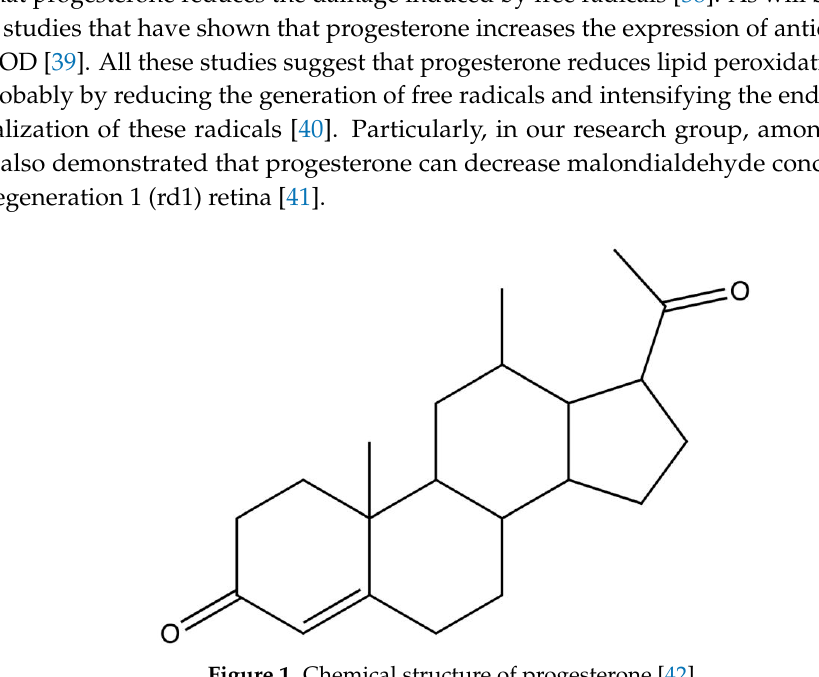
Figure 1. Chemical structure of progesterone [42].